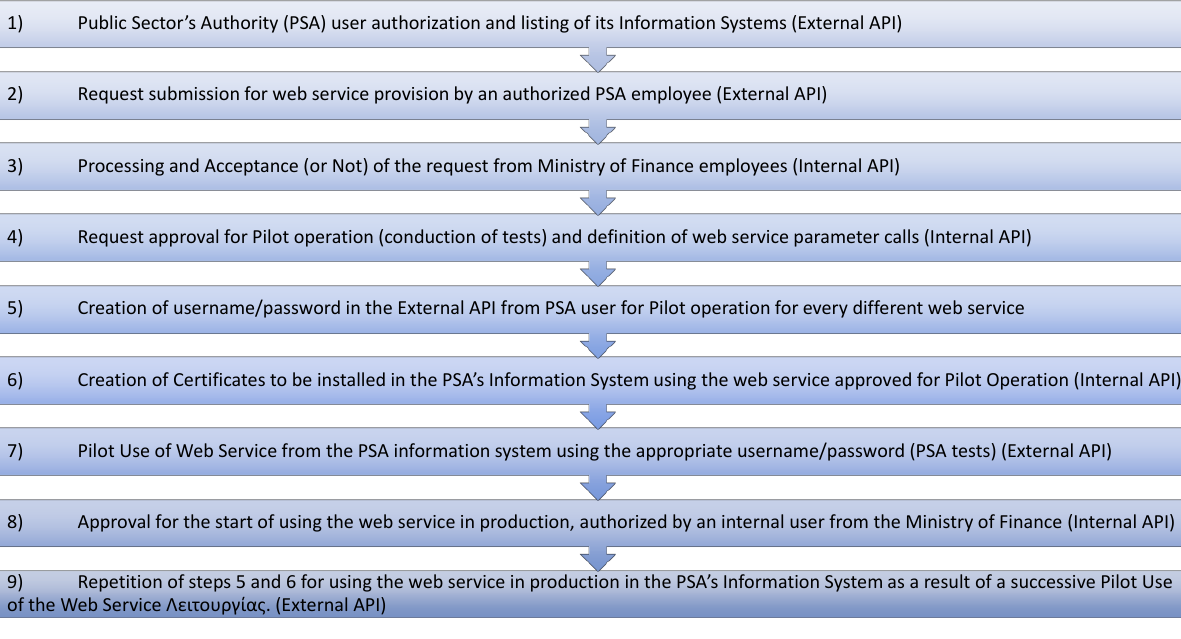
Figure 3: Existing Web Service provision and ESB proposed